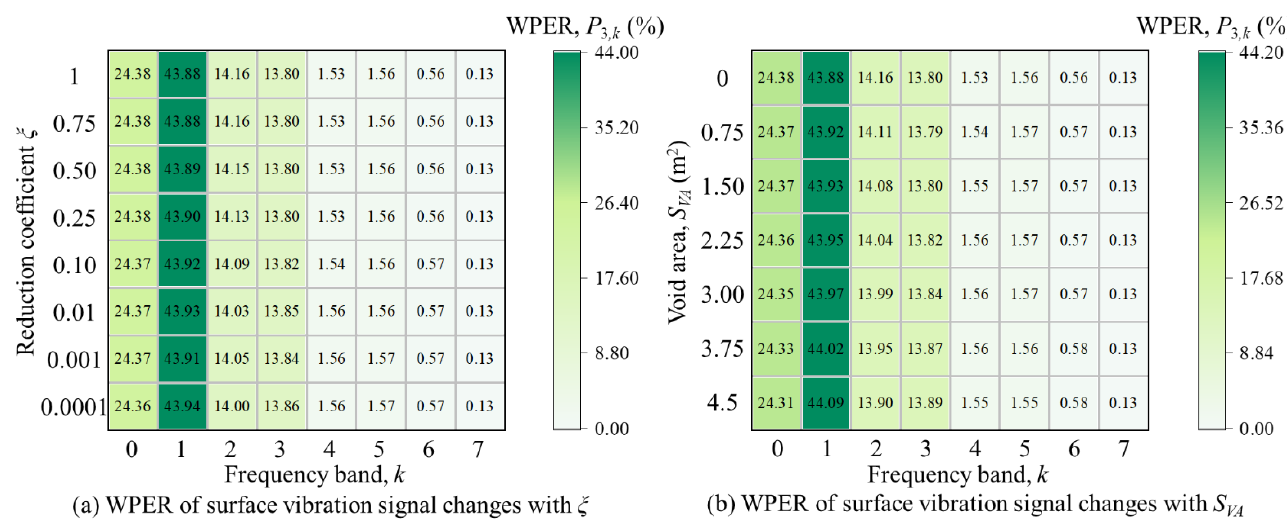
Figure 14. Energy distribution characteristics of vibration signal at monitor point 2.